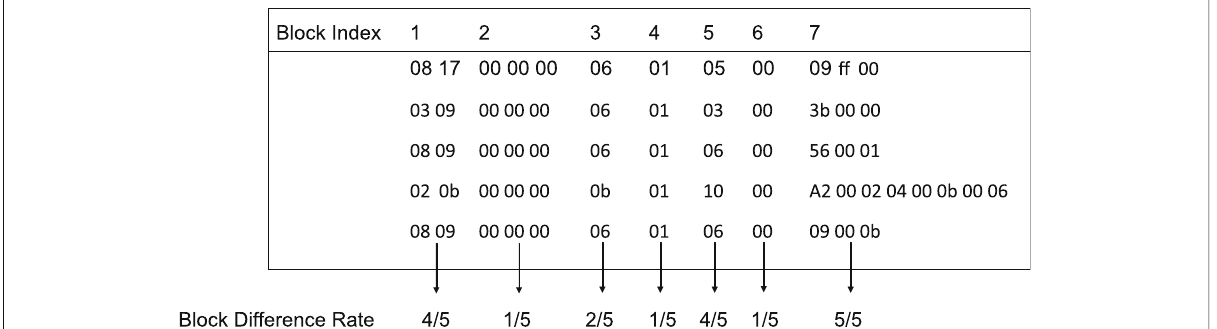
Fig. 7 The example of the block difference rate. After the data are divided, the block difference rate can be calculated from the different types of values in the same column. Each column represents a block. Taking the first column as an example, the block difference rate is 4